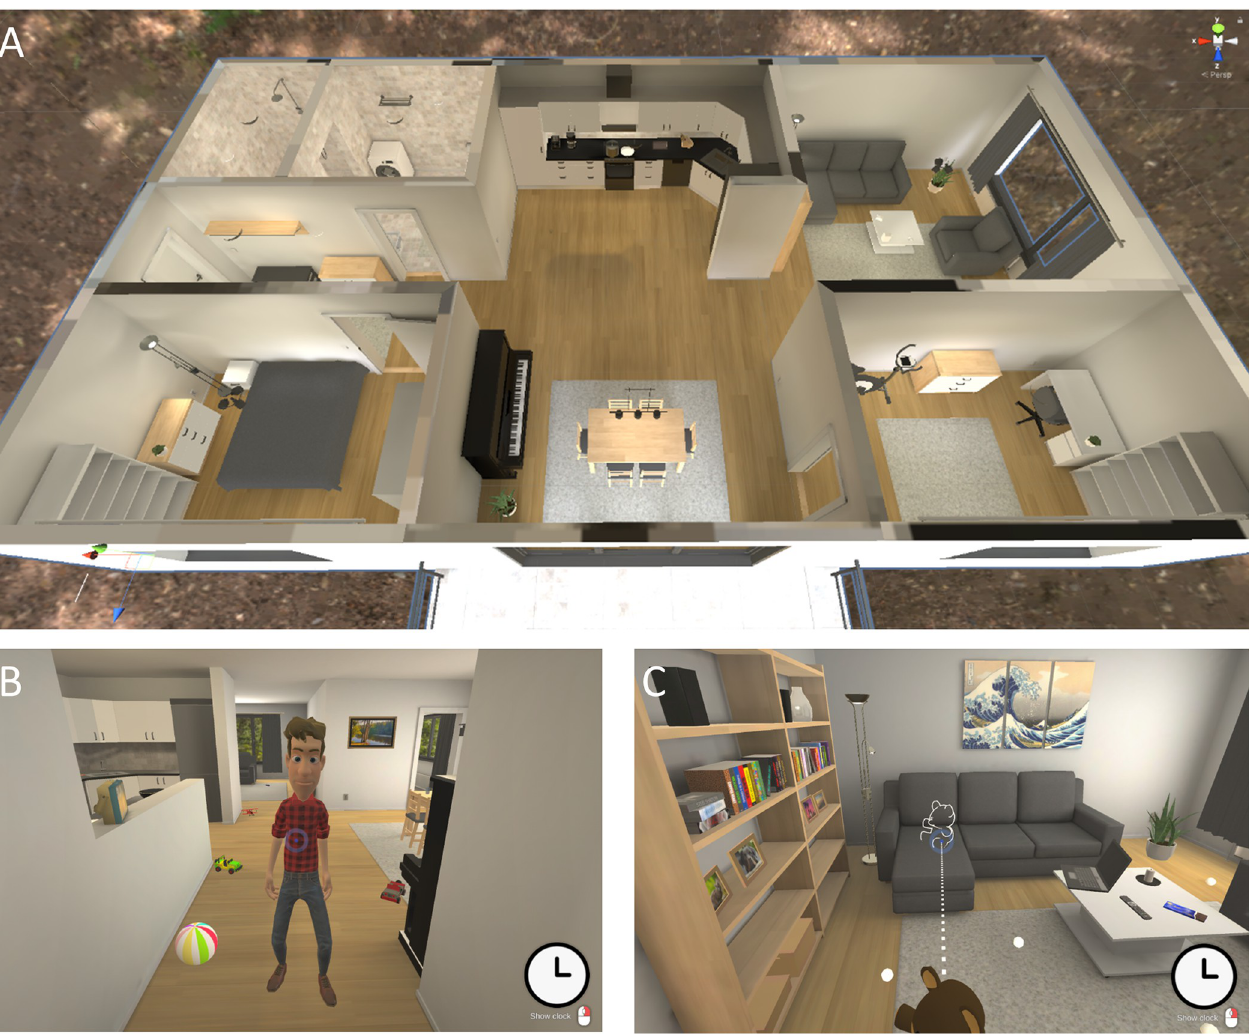
Fig 1. The EPELI game. In the game, the participants performed everyday chores in a virtual apartment. The floorplan (panel A) was not shown to the participant. The to-be-remembered list of tasks was given by the virtual character Vincent at the beginning of each task block (panel B). The event-based task was to place the teddy bear, if seen amidst the toys scattered on the floor, on the sofa (panel C). The participant could move around by clicking on white hotspots on the floor. A clock with running time could be opened by clicking the right mouse button.